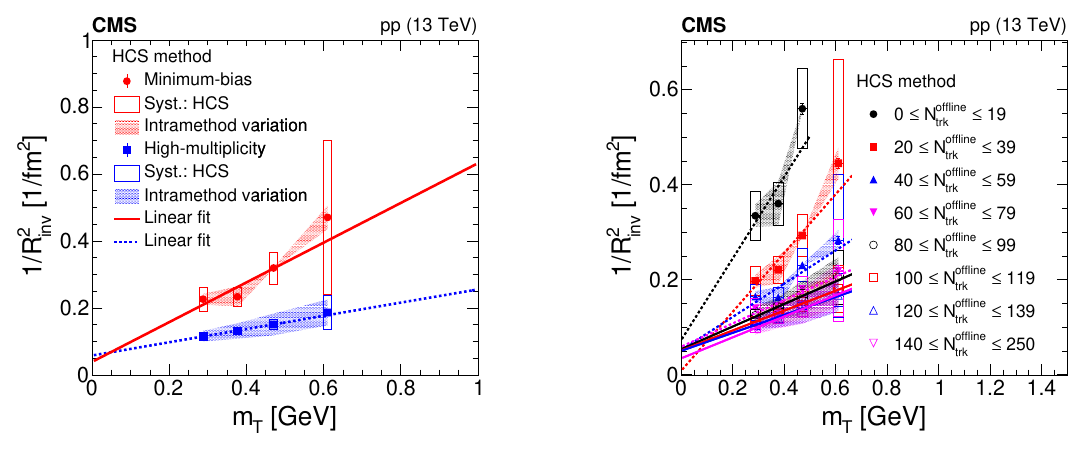
Figure 7 . The distribution 1 =R 2 as a function of m for the HCS method. Results corresponding inv T to the MB range (0 (cid:20) N o(cid:15)ine (cid:20) 79) and to the HM one (80 (cid:20) N o(cid:15)ine (cid:20) 250) are shown (left). trk trk Results are also shown in more di(cid:11)erential bins of multiplicity (right). Statistical uncertainties are represented by the error bars, systematic uncertainties related to the HCS method are shown as open boxes, and the relative uncertainties from the intramethods variation are represented by the shaded bands. Only statistical uncertainties are considered in all the